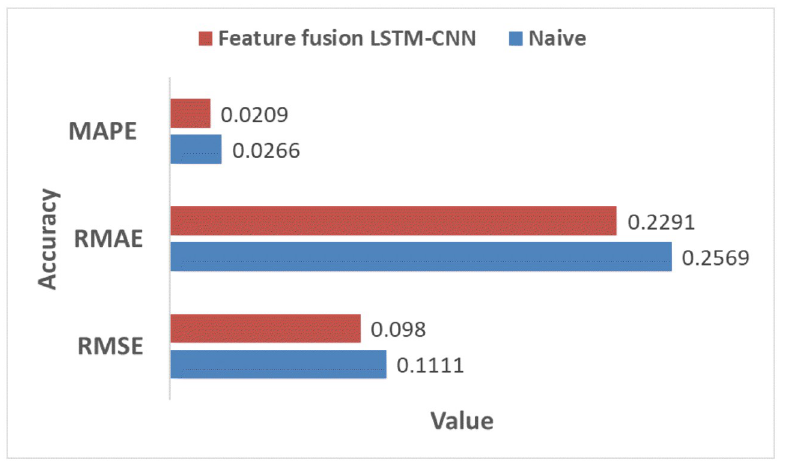
Fig 13. Comparison of accuracy between feature fusion LSTM-CNN and naive model.